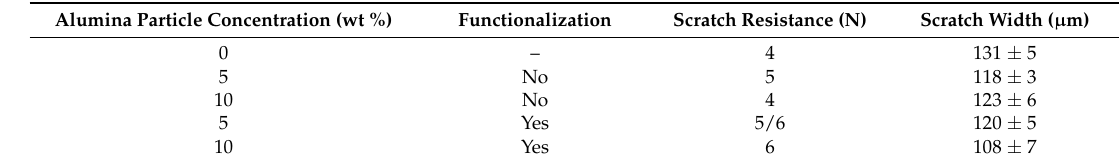
Table 1. Scratch resistance (according to standard NS-EN 438-2) and scratch widths (from micro scratch testing) of laminates containing as-received and functionalized alumina particles.